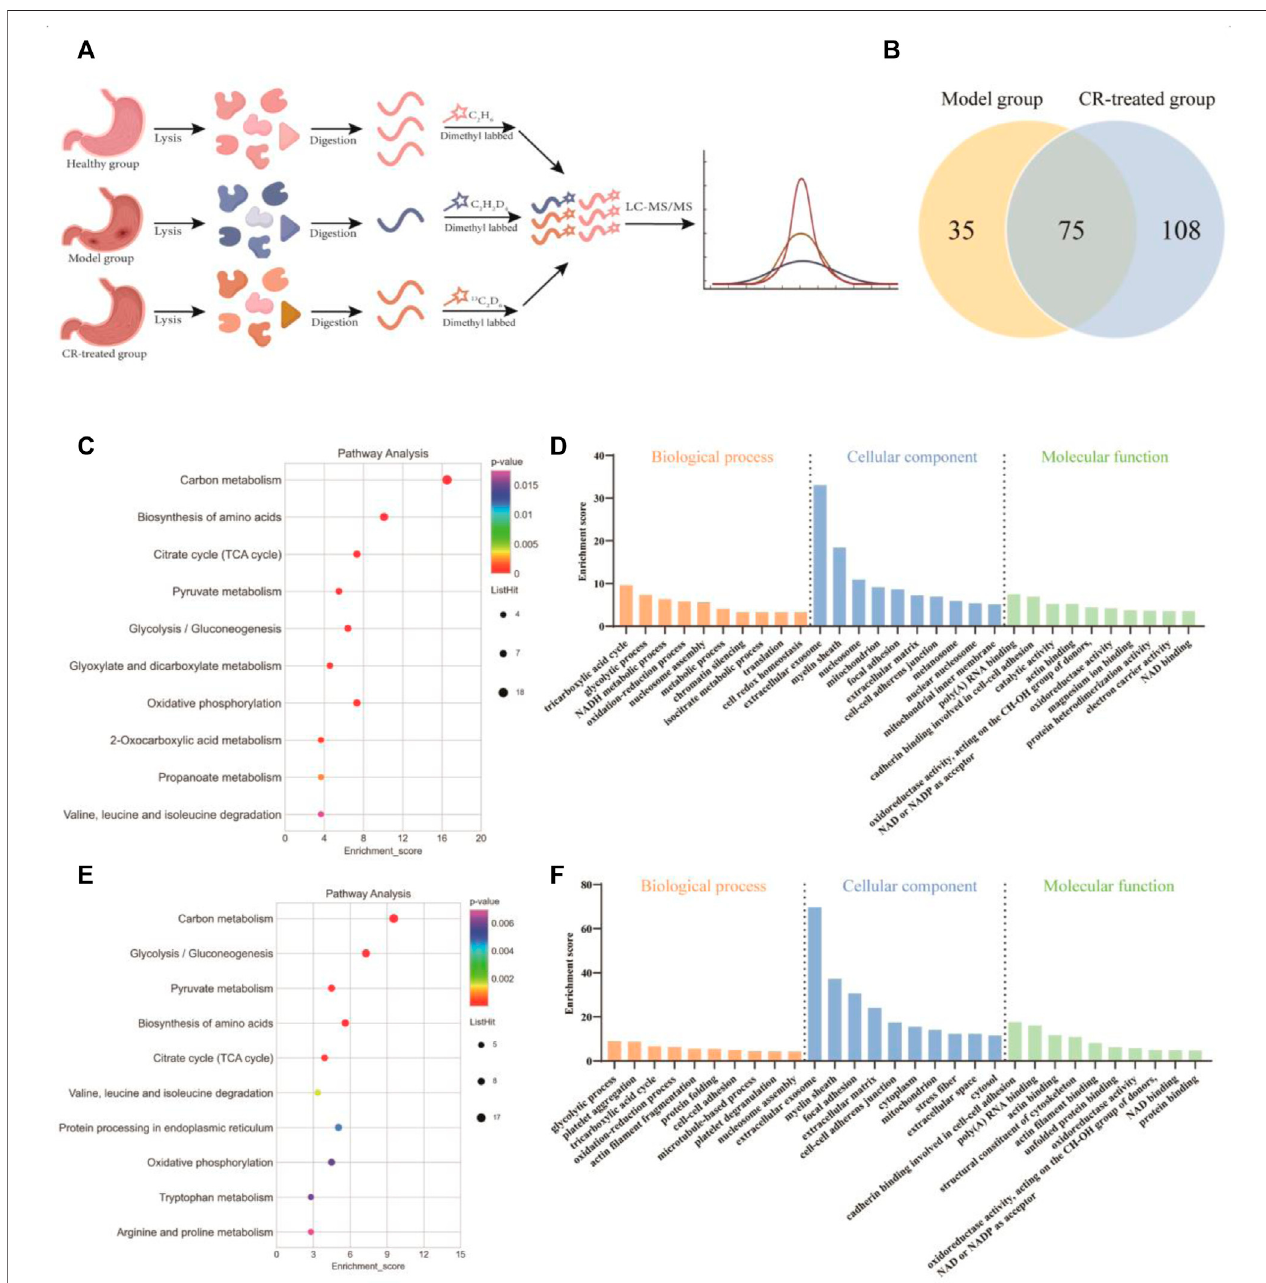
FIGURE2| Quantitative proteomicsanalysis of CR. (A) Schematicdiagram ofquantitativeproteomics experiments. (B) Venn diagram showingthenumber of intervened proteins in the model group and CR-treated group. (C,D) Analysis of KEGG pathway and biological function (model group vs. healthy group) based on quantitative proteomics. (E,F) Analysis of KEGG pathway and biological function (CR-treated group vs. model group) based on quantitative proteomics.